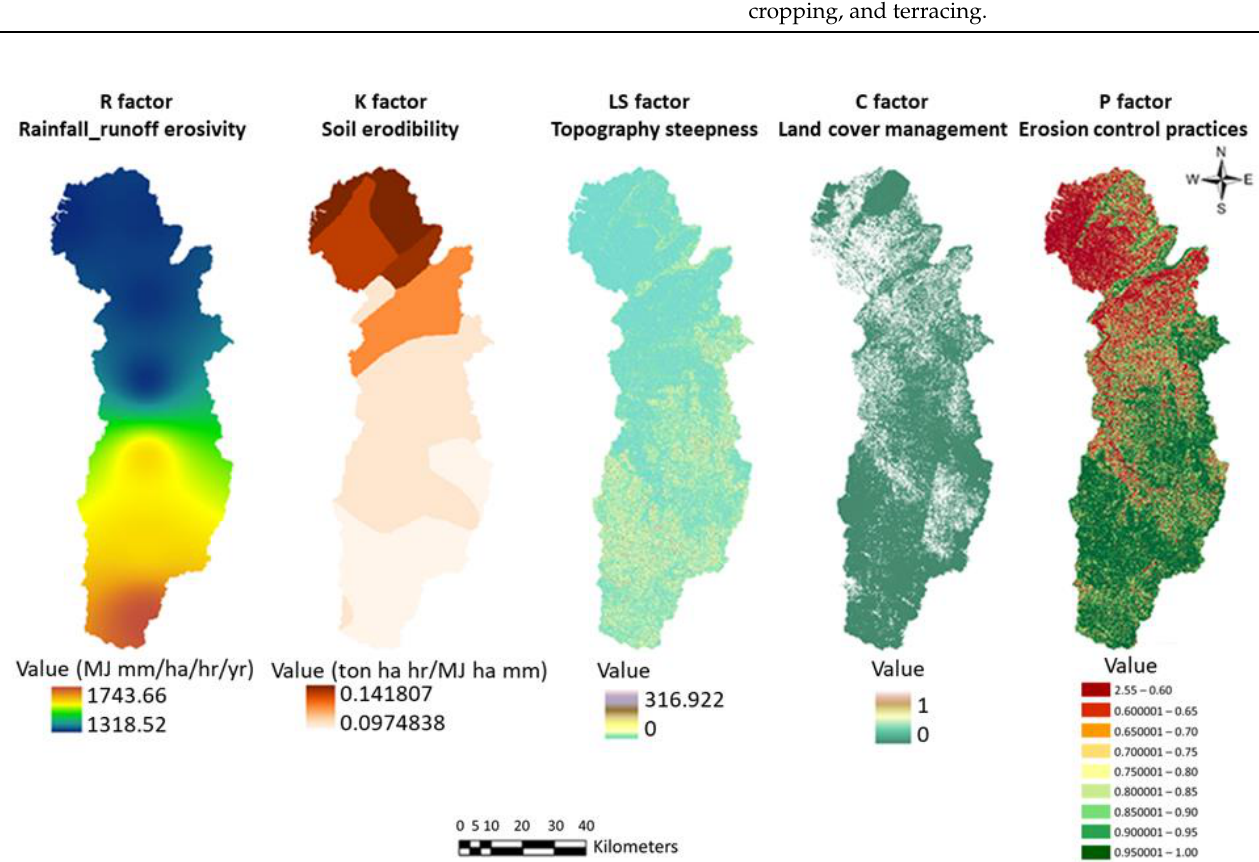
Figure 3. Key inputs variables for (R, K, LS, C, P) soil loss assessment.